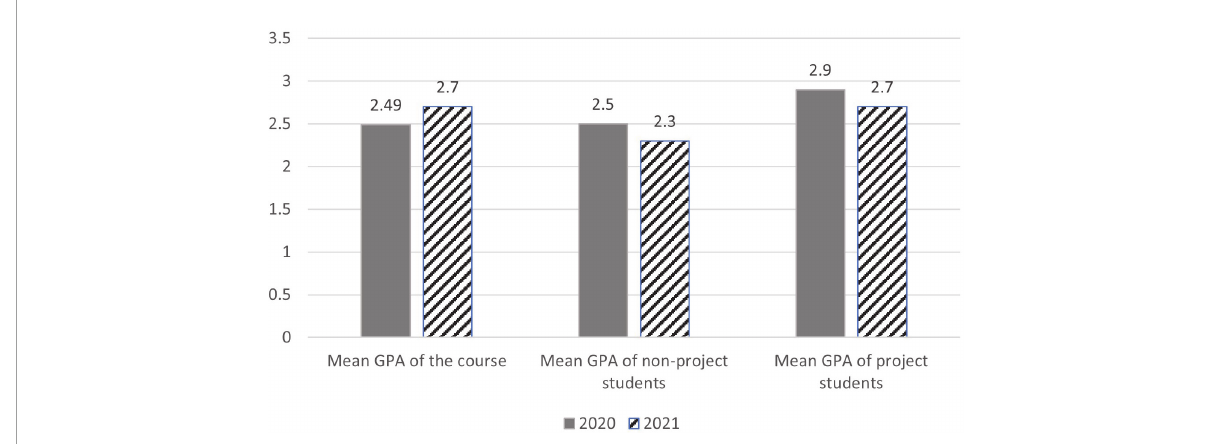
FIGURE1 Student GPA: comparison between project and non-project students in 2020 and 2021.